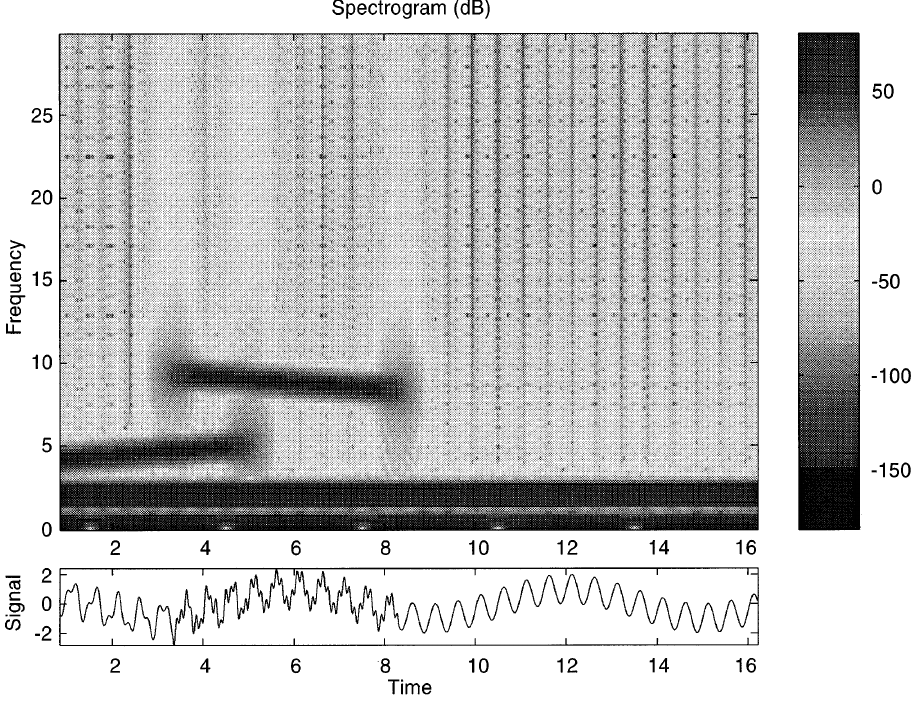
Fig. 2. Spectrogram of the synthetic signal in the noise-free case; frequencies are in h